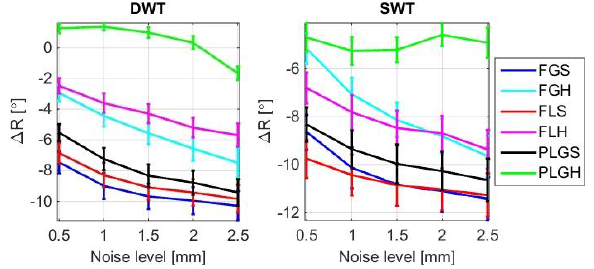
Figure 8. Error plot of ΔR versus noise levels for DWT (left) and SWT (right) denoised surfaces applying six thresholds.